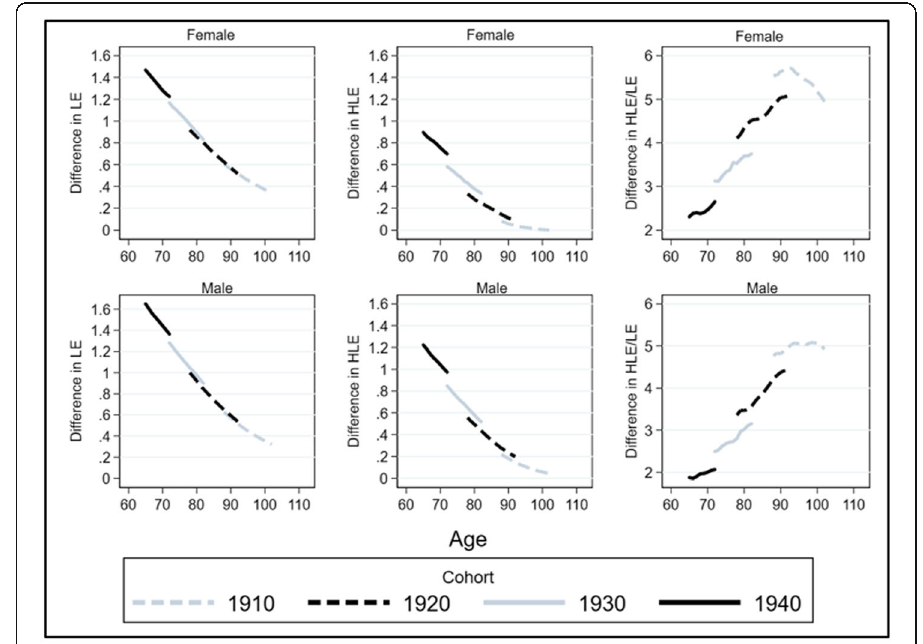
Fig. 3 The discrepancy in life expectancy and healthy life expectancy in different cohorts, at different ages with different education